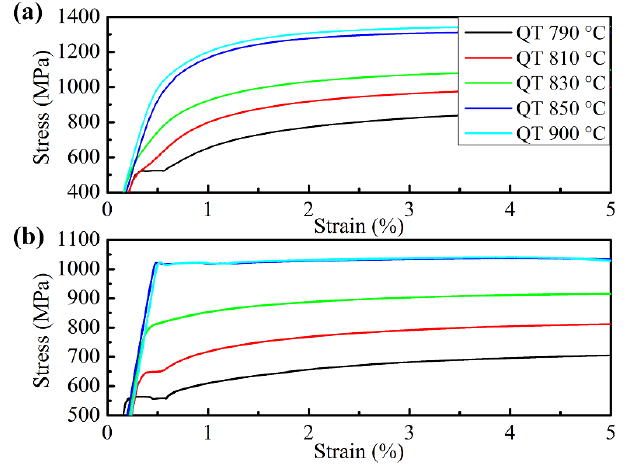
Figure 5. Yielding stage of stress–strain curves of specimens quenched from different temperatures and tempered at ( a ) 180 °C and ( b ) 450 °C, respectively (QT = quenching temperature). and tempered at ( a ) 180 ◦ C and ( b ) 450 ◦ C, respectively (QT = quenching